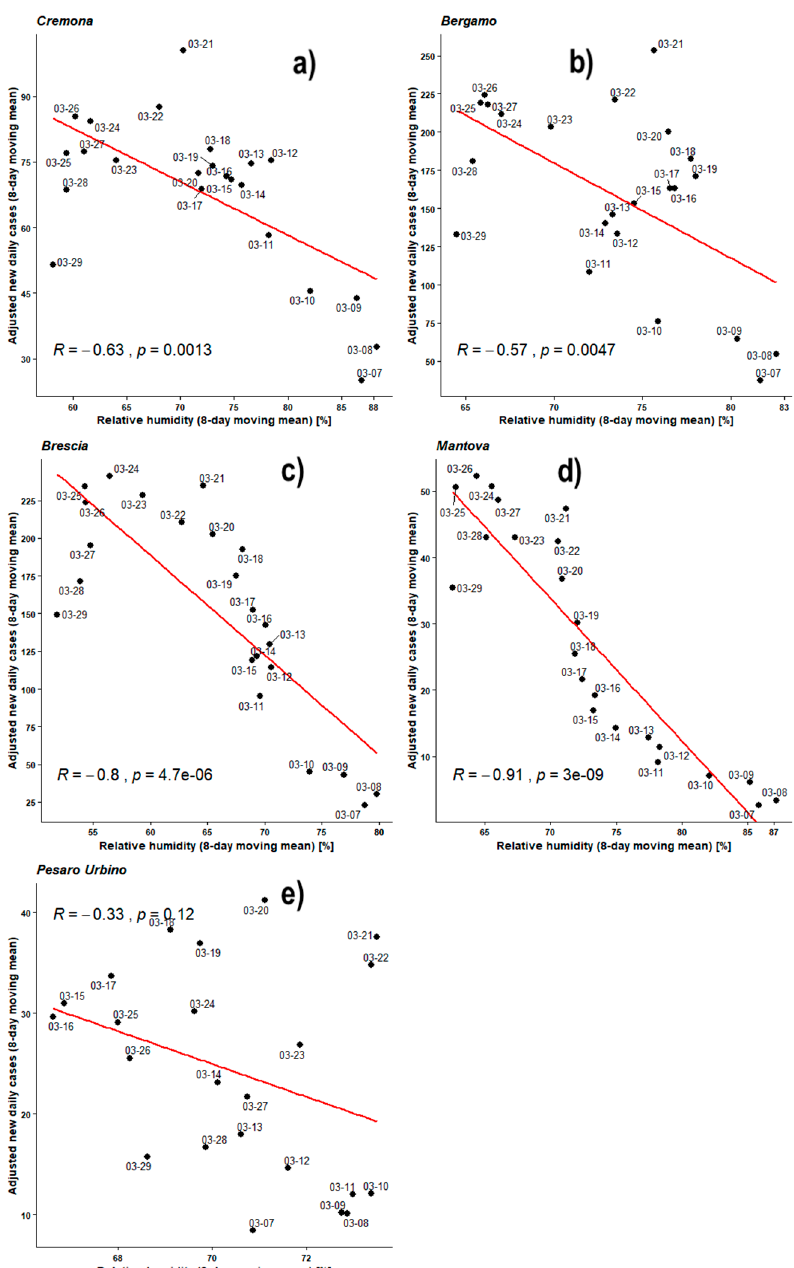
Figure 11. Scatter plot and linear regression for the 8-day moving means of adjusted new daily cases against relative humidity for five Italian provinces: ( a ) Cremona, ( b ) Bergamo, ( c ) Brescia, ( d ) Mantova, ( e ) Pesaro Urbino. Labels report, in MM-DD format, the last day of the moving means. Pearson correlation coe ffi cient is reported as ‘R’ while probability value is reported as ‘ p ’.